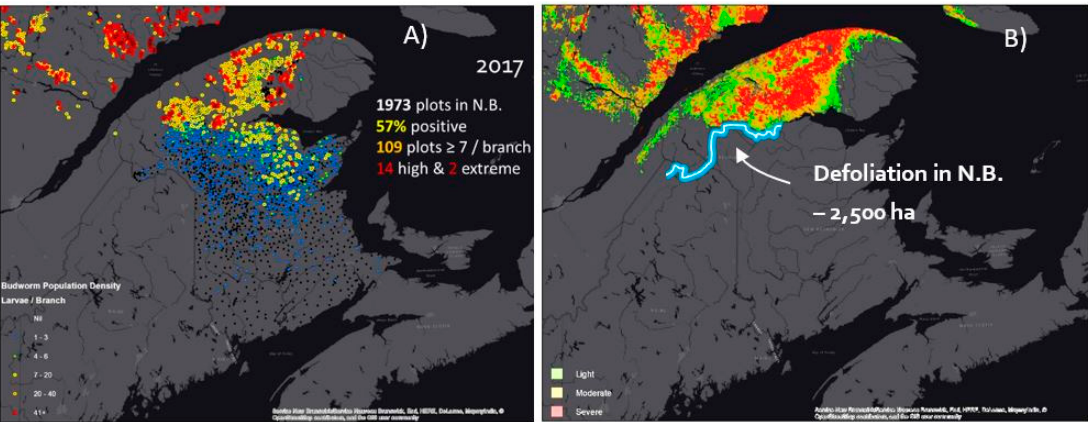
Figure 7. SBW L2 population ( A ) and aerial survey defoliation ( B ) in 2017, after 4 years of EIS treatments in northern New Brunswick and adjacent Québec (the border between the two provinces is indicated by the blue line in (B)).